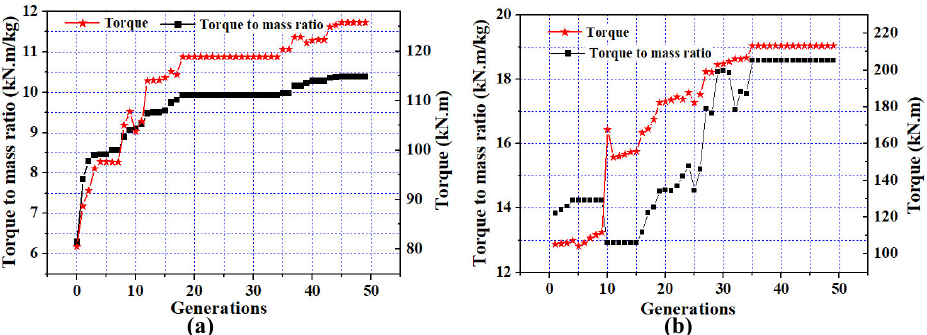
Figure 8. Objective function and torque evolution as a function of generations number: ( a ) TDSPM with two coils/phase structures, ( b ) TDSPM with four coils/phase